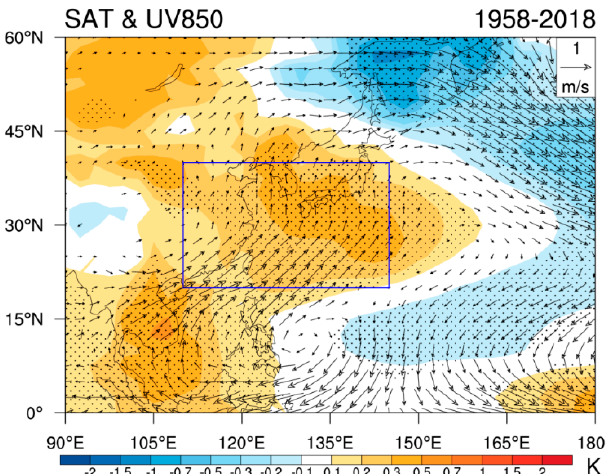
Figure 1. The wintertime (December to February) surface air temperature (SAT) (shading) and 850 hPa wind anomalies regressed onto the simultaneous normalized Niño-3 index during 1958–2018. Dots indicate the 90% confidence level based on a two-tailed Student’s t -test. Vectors exceeding 0.1 m/s are shown. The blue box indicates the region to define the East Asian surface air temperature (EAT) index.